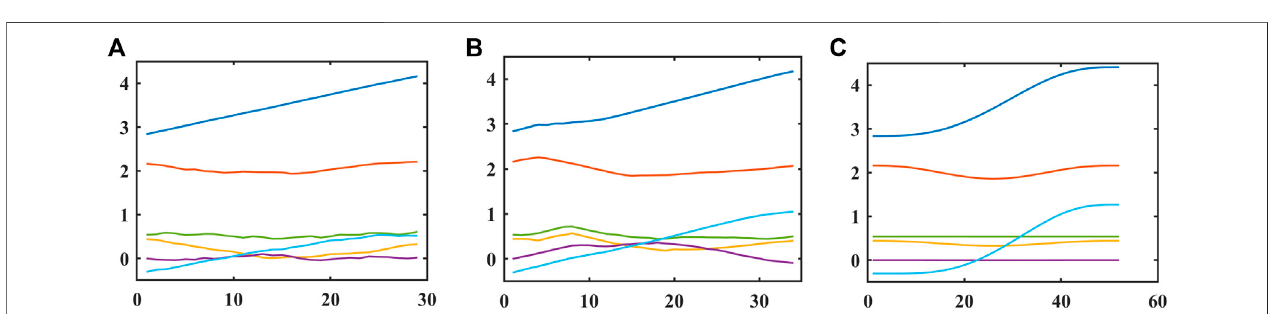
Frontiers in Energy Research |